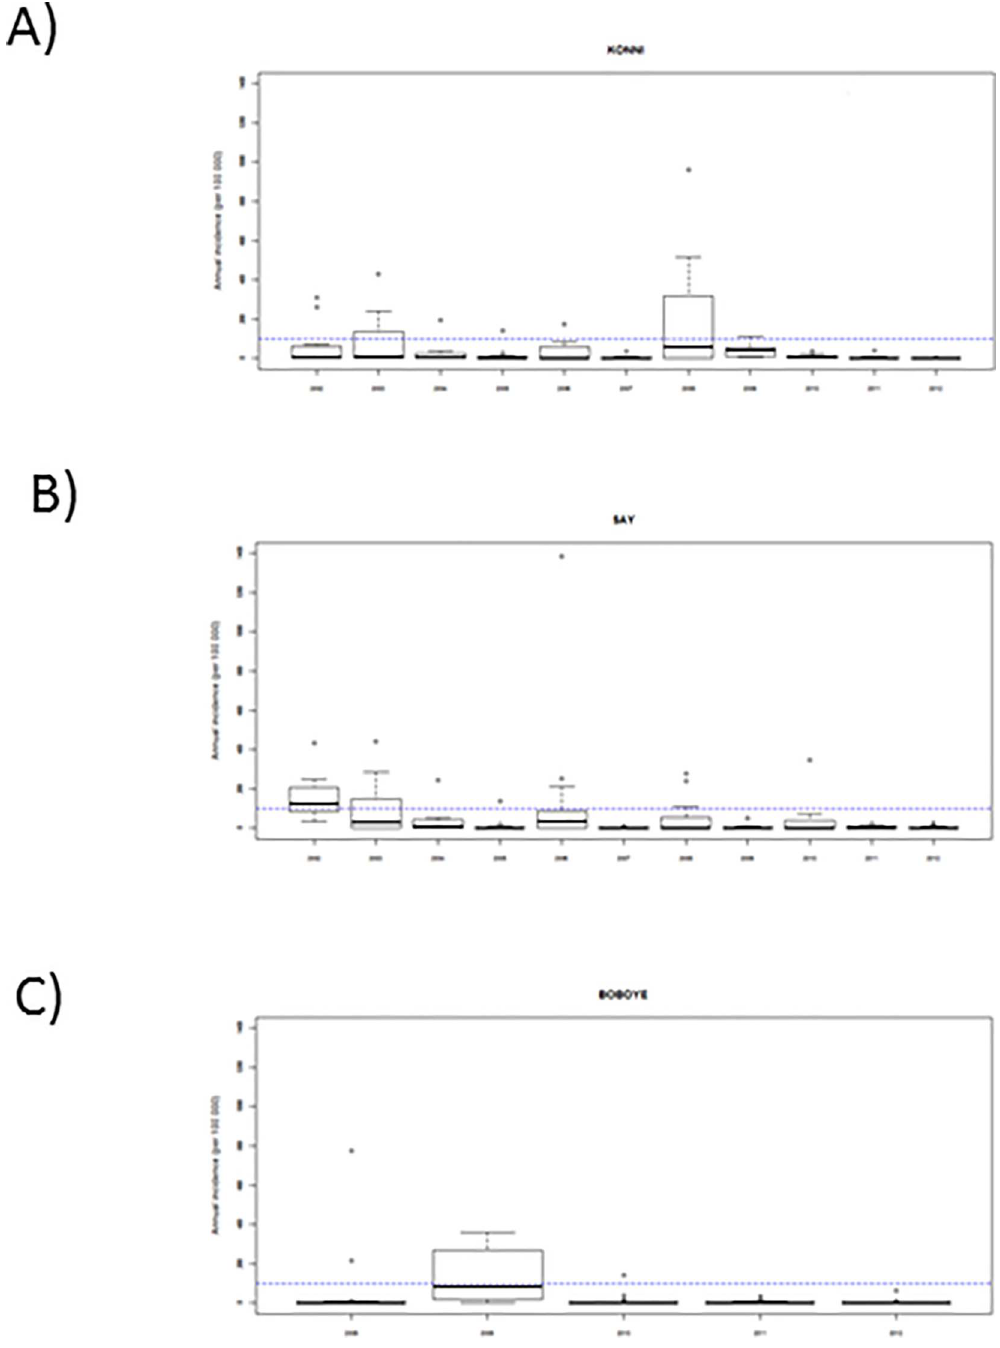
Fig 1. Annual meningitis incidences at health area level in three selected districts, Niger, 2002–2012. One district was selected for illustration in each of the three regions: A) Konni district in Tahoua region, B) Say district in Tillabery region, and C) Boboye district in Dosso region. Boxplots show median, 25 th and 75 th percentileand range of annualincidencesin the health areas of the district. Dotted lines indicate annualincidenceof 100 per 100,000, a threshold previouslyused as a retrospective definitionof epidemicsat the district level. 13 The epidemiologicalyear n , from 1 st July of calendar year n-1 to 30 th June of calendaryear n , is used